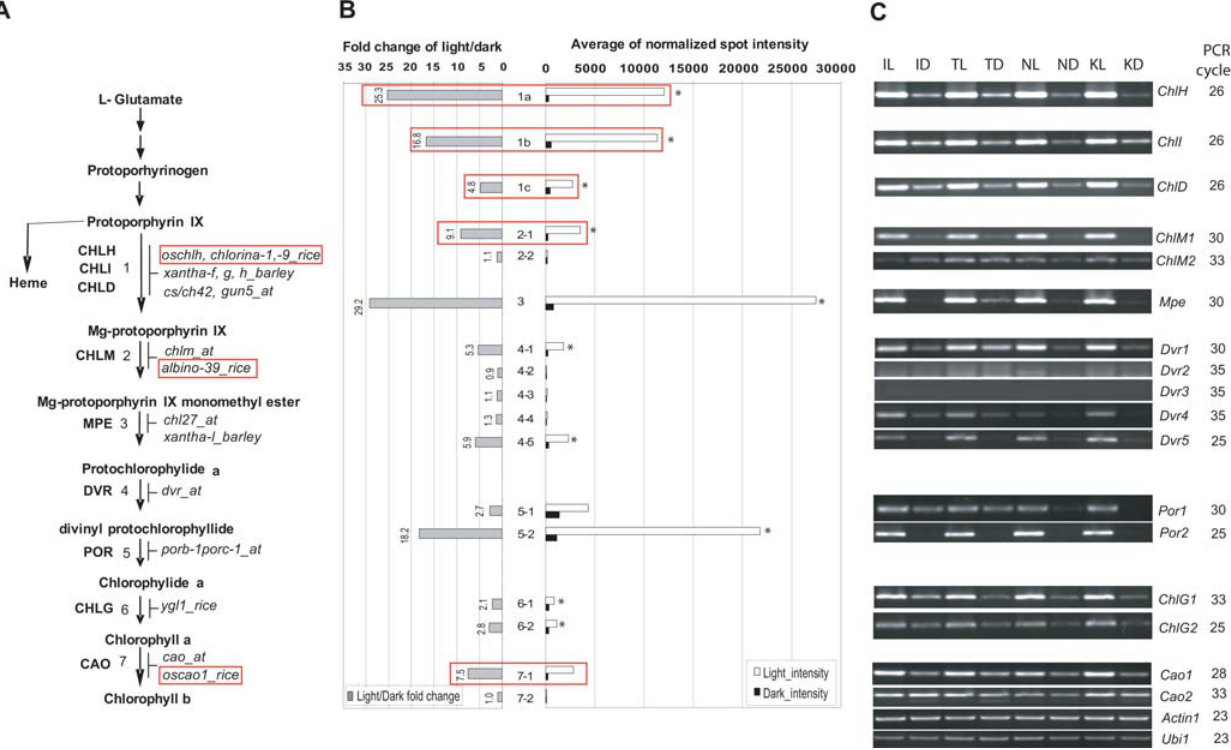
Figure 1. Light-Responsiveness of Rice Genes Involved in the Chlorophyll Biosynthesis Pathway. (A) The seven steps in the rice chlorophyll biosynthesis pathway, from magnesium chelatase to chlorophyll b, are shown and mutants of rice corresponding to each step are indicated. Red boxes indicate mutants which have been characterized in rice. CHLH, magnesium-chelatase subunit H family protein (1); CHLI, magnesium-chelatase subunit I family protein (1); CHLD, magnesium chelatase ATPase subunit D protein (1); CHLM, magnesium-protoporphyrin O- methyltransferase (2, and there were two gene family members); MPE, magnesium-protoporphyrin IX monomethyl ester cyclase (3); DVR, divinyl protochlorophyllide reductase (4, and there were five gene family members); POR, protochlorophyllide reductase (5, and there were four gene family members); CHLG, chlorophyll synthase (6, and there were two gene family members); and CAO, chlorophyll a oxygenase (7, and there were two gene family members). oschlh , chlorina-1 , and -9 are mutants in rice ChlH , ChlI , ChlD , respectively; xantha-f , g , and h are mutants in barley ChlH , ChlI , ChlD , respectively; cs/ch42 is mutant in Arabidopsis CHLI ; gun5 is mutant in Arabidopsis CHLH ; chlm is mutant in Arabidopsis CHLM ; albino-39 is mutant in rice ChlM ; Chl27 is mutant in Arabidopsis MPE ; xantha-i is mutant in Barley Mpe ; dvr is mutant in Arabidopsis DVR ; porb-1porc-1 is double mutant of Arabidopsis PORB and PORC ; ygl1 is mutant of rice ChlG ; cao is mutant of Arabidopsis CAO ; and oscao1 is mutant of rice Cao1 . (B) Normalized average expression levels in light and dark and fold changes in expression from dark to light based on results of the NSF45K light vs. dark microarray experiment are shown for genes involved in the 7 steps in the pathway and their gene family members. Unique genes or gene family members predominantly expressed in the light in each step are marked with asterisks. White boxes indicate gene expression levels in light. Black boxes indicate gene expression levels in dark. Gray boxes indicate the fold change ratios of light over dark. Red boxes indicate the gene expression patterns of the genes corresponding to those mutations in red boxes of A. 1a , Os03g20700 ; 1b , Os03g36540 ; 1c , Os03g59640 ; 2-1 , Os06g04150 ; 2-2 , Os02g35060 ; 3 , Os01g17170 ; 4-1 , Os03g22780 ; 4-2 , Os02g56690 ; 4-3 , Os08g17500 ; 4-4 , Os08g34280 ; 4-5 , Os09g25150 ; 5-1 , Os04g58200 ; 5-2 , Os10g35370 ; 6-1 , Os05g28200 ; 6-2 , Os03g09060 ; 7-1 , Os10g41780 ; and 7-2 , Os10g41760 . (C) RT-PCR results are shown; Ubq1 and Actin1 were used as controls [85]. Numbers of PCR cycles are indicated. IL, leaves from IR24 plants harvested in the light; ID, leaves from IR24 plants harvested in the dark; TL, leaves of Taipei (TP) 309 plants harvested in the light; TD, leaves of TP309 plants harvested in the dark; NL, leaves of Nipponbare plants harvested in the light; ND, leaves of Nipponbare plants harvested in the dark; KL, leaves of Kitaake plants harvested in the light; and KD, leaves of Kitaake plants harvested in the dark. ChlH , Os03g20700 ; ChlI , Os03g36540 ; ChlD , Os03g59640 ; ChlM , Os06g04150 , Os02g35060 ; Mpe , Os01g17170 ; Dvr1 , Os03g22780 ; Dvr2 , Os02g56690 ; Dvr3 , Os08g17500 ; Dvr4 , Os08g34280 ; Dvr5 , Os09g25150 ; Por1 , Os04g58200 ; Por2 , Os10g35370 ; ChlG1 , Os05g28200 ; ChlG2 , Os03g09060 ; Cao1 , Os10g41780 ; and Cao2 , Os10g41760